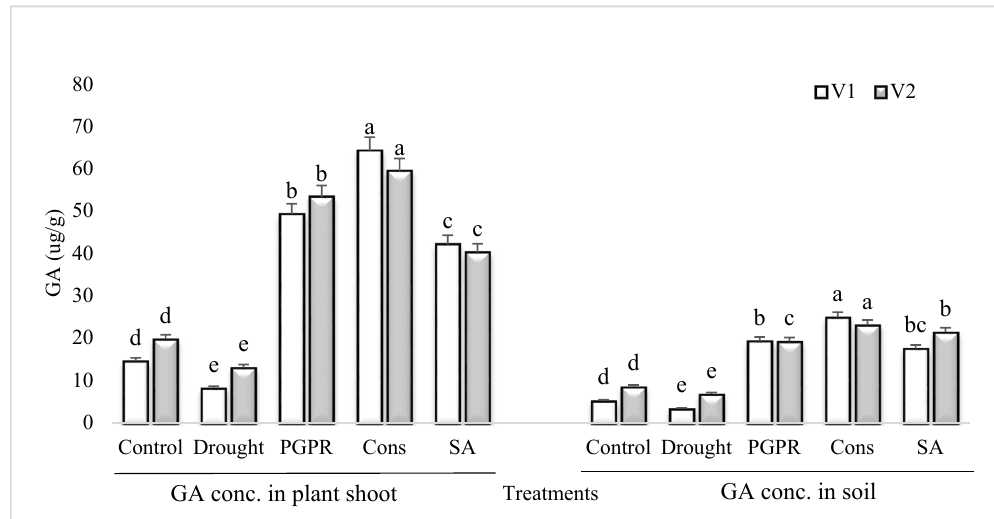
Figure 6. GA content in plant shoot and rhizosphere of drought sensitive and tolerant varieties grown under rainfed conditions. V1: drought sensitive variety; V2: drought tolerant variety. Different significance levels were denoted with different letters (a, b, c, d and e).